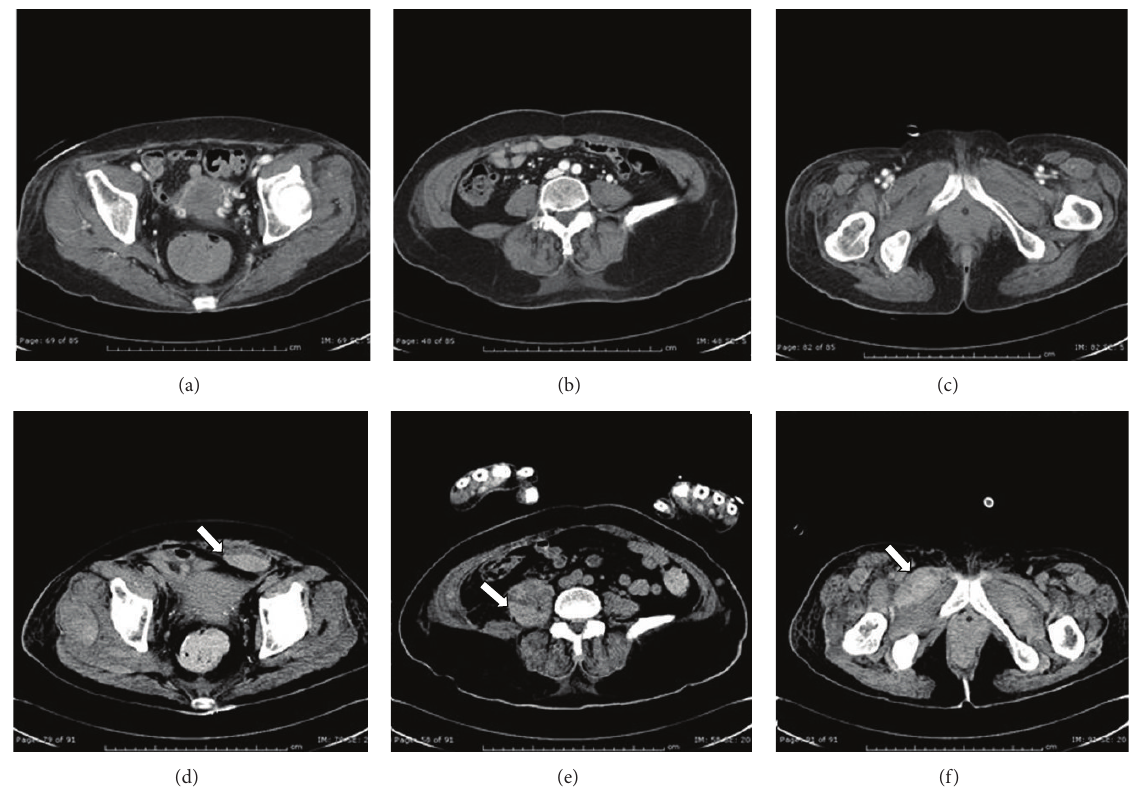
Figure 8: CT scan of the abdomen and pelvis before and after bleeding. (a–c) CT scan with contrast shows (a) normal rectus, (b) normal iliopsoas, and (c) normal pectineus muscles. (d–f) CT scan without contrast shows bleeding into (d) rectus sheath (arrow), (e) iliopsoas (arrow), and (f) pectineus muscles